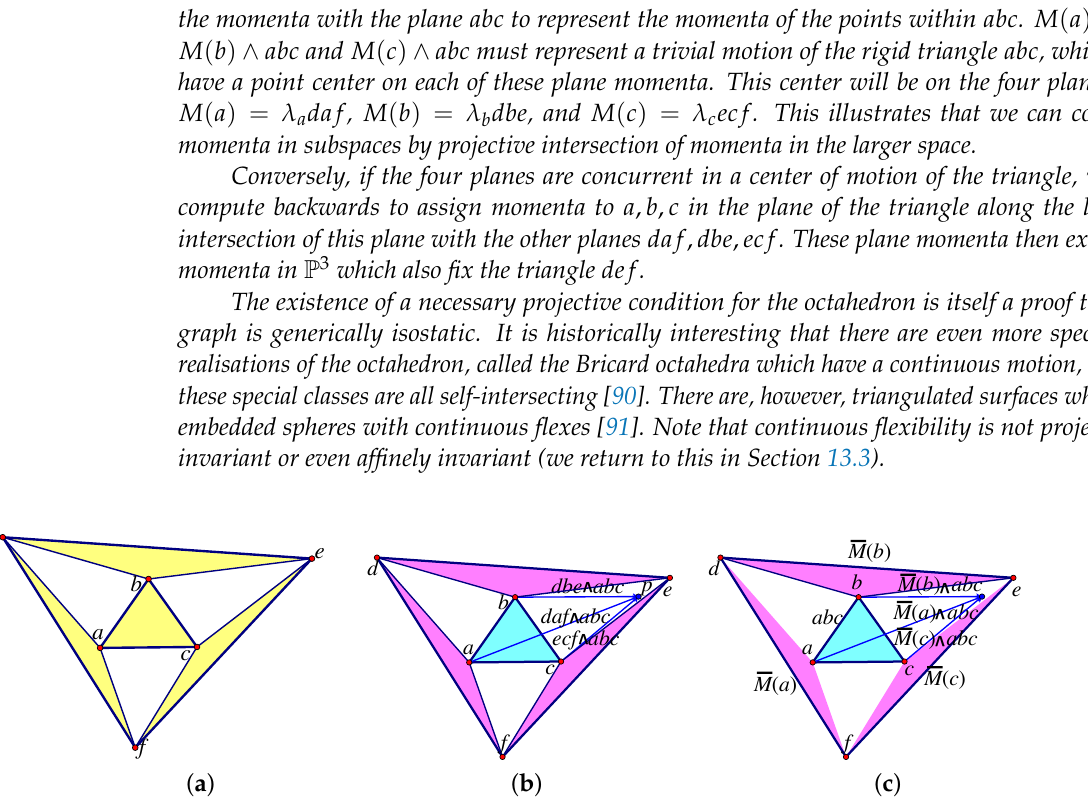
Figure 21. The octahedron is infinitesimally flexible in 3-space if and only if four opposite faces are concurrent ( a ). For an equilibrium stress, the components of the equilibrium stress in the plane of a , b , c must lie in the plane at a , b , c and meet in a point p in the plane ( b ). The momenta for vertices a , b , c intersect the plane of triangle abc in plane momenta which meet in a point p –the center of motion of the triangle—which is on all four planes ( c